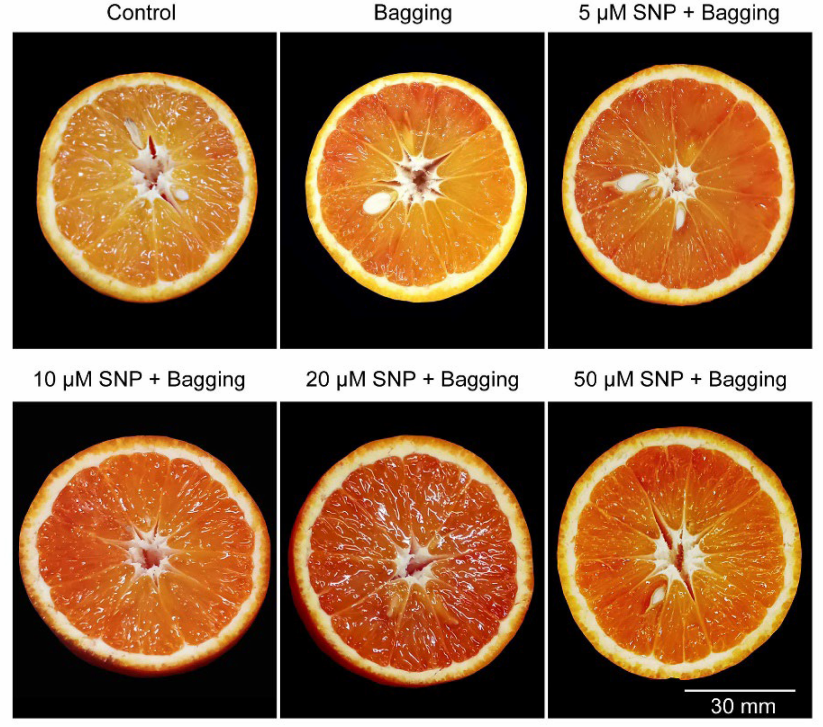
Figure 1. Effects of bagging treatments with 0 − 50 µ M SNP on pulp